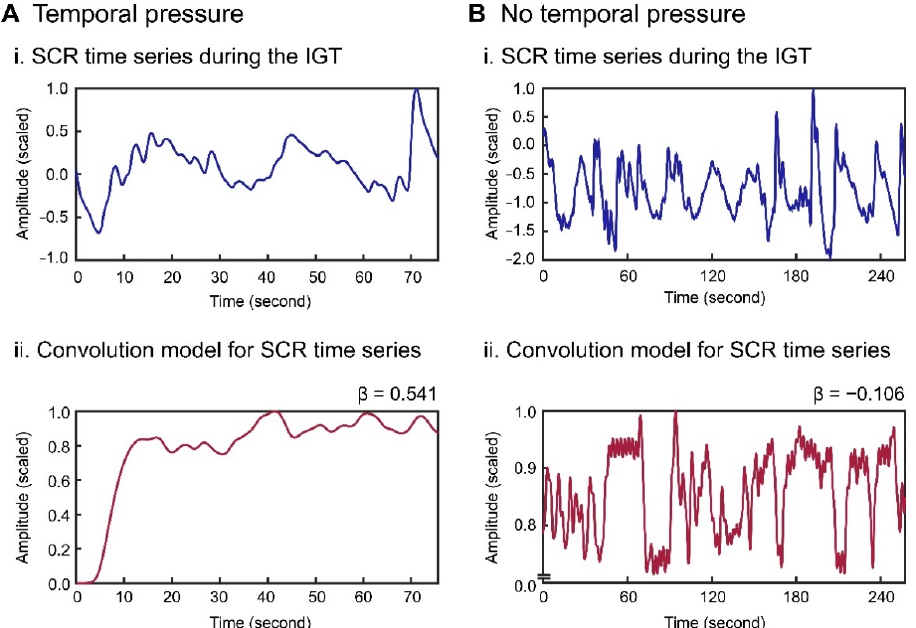
Figure 3. SCR time series recorded during the IGT ( i ) and the corresponding linear convolution model (6-s delay model) using SCRFs ( ii ) for one participant under the temporal pressure conditions ( A ) and the no temporal pressure conditions ( B ).